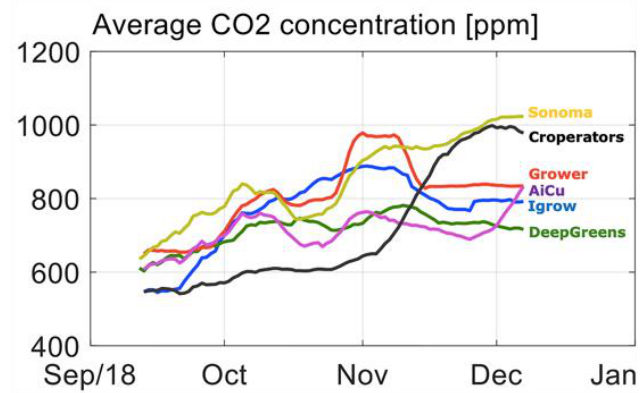
Figure 8. Course of CO 2 concentration in ppm in different compartments during the cucumber experiment.